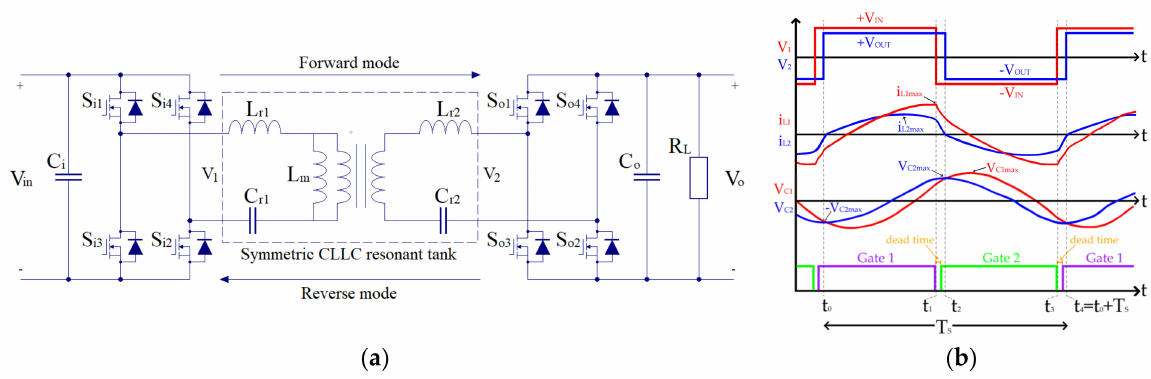
Figure 6. Typical bidirectional FB-CLLC resonant converter: ( a ) Operation of forward and reverse modes; ( b ) Waveforms of the resonant frequency in the forward